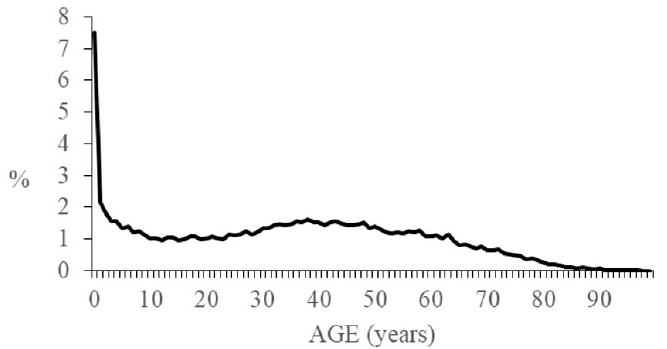
Figure 1. Distribution per age at diagnosis in patients with rare diseases. Veneto Region Rare Diseases registry, 2016.